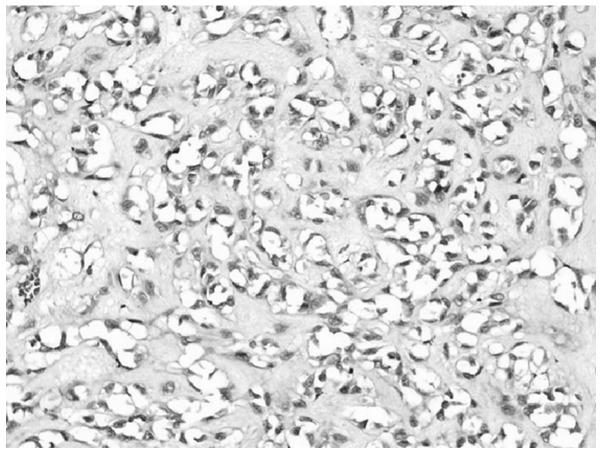
The collagen fibers.